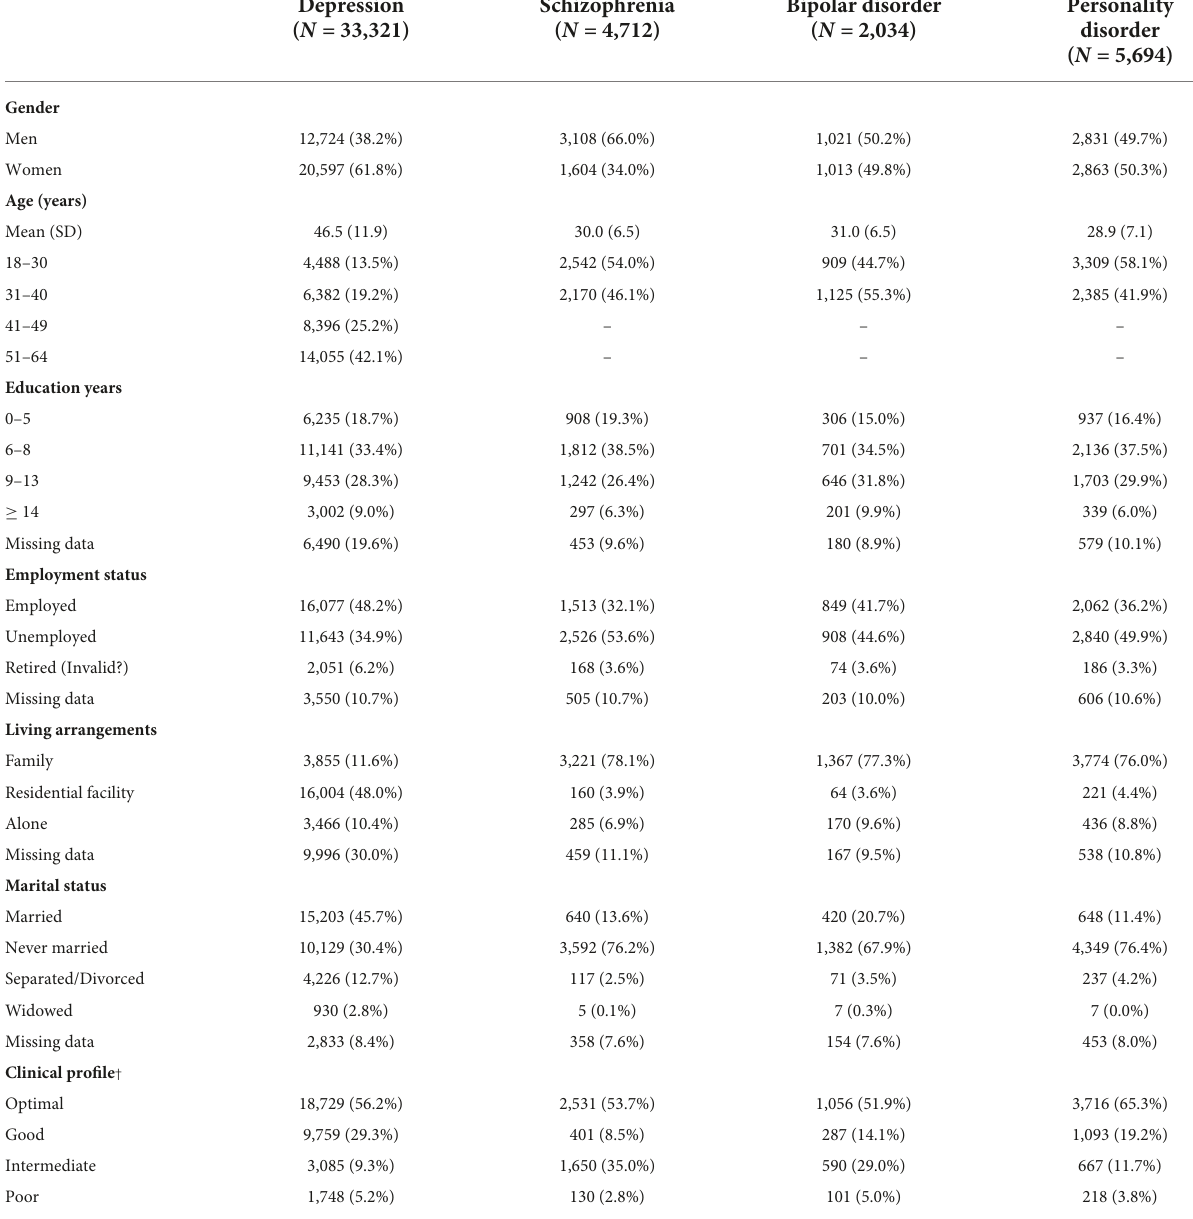
TABLE 1 Baseline characteristics of patients newly taken-into-care for severe mental disorders according with the main diagnosis. QUADIM-MAP project, Italy,